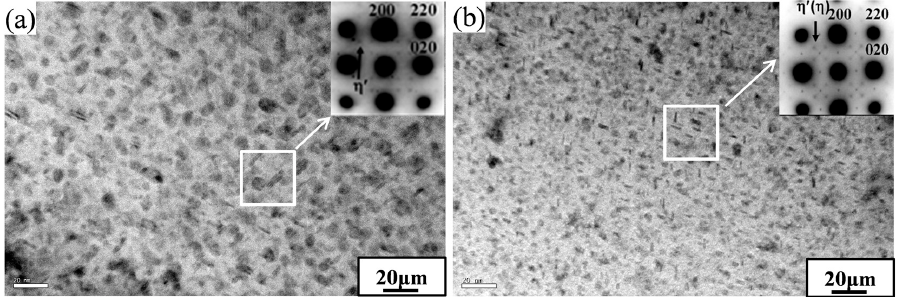
Figure 3. TEM images of the T6- and T6-DCT-treated 7A99 aluminum alloy (zone axis = [001]). ( a ) T6; and ( b ) T6-DCT.